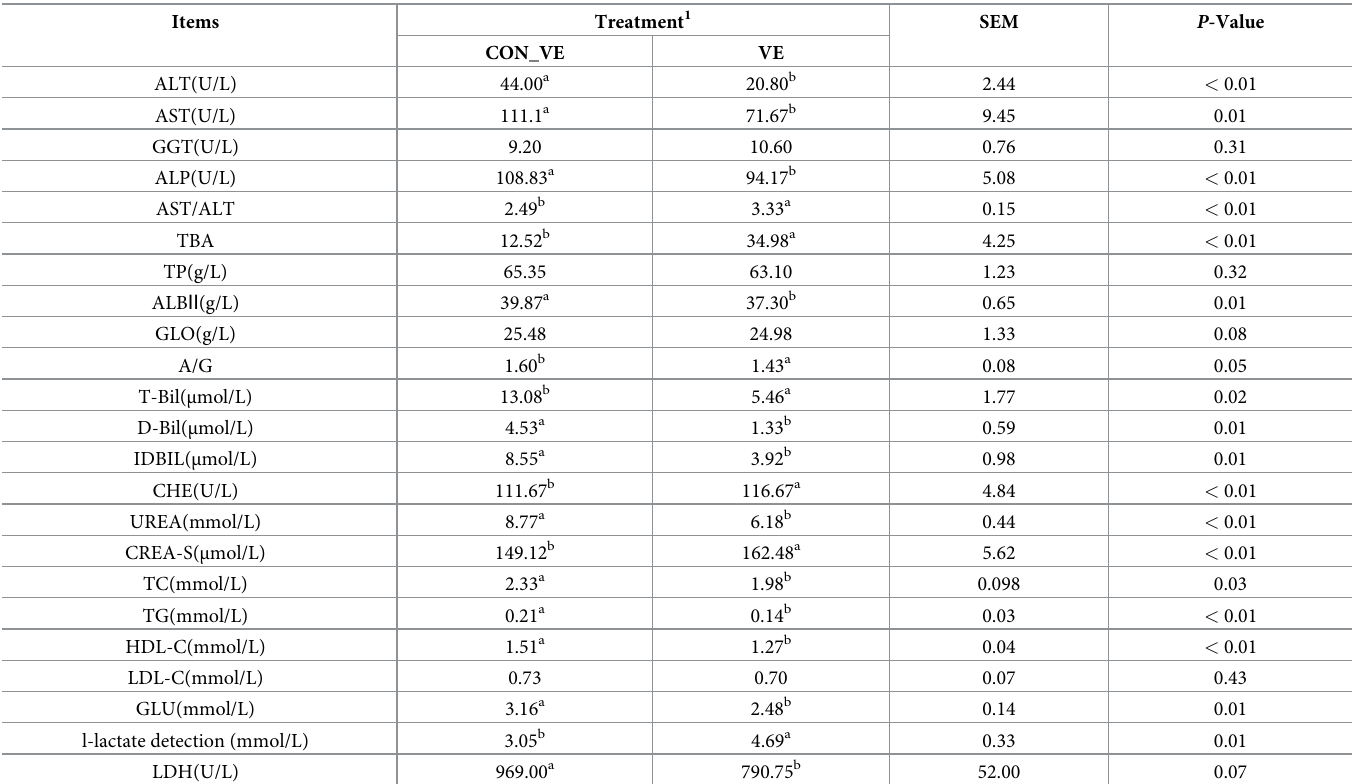
Table 1. Blood biochemical indices before and after VE injection after transportation in yak. Items